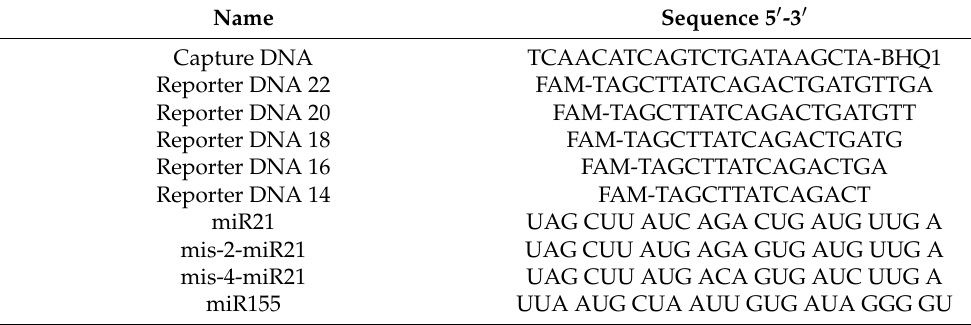
Table 1. Sequences of DNA or RNA used in the experiments.